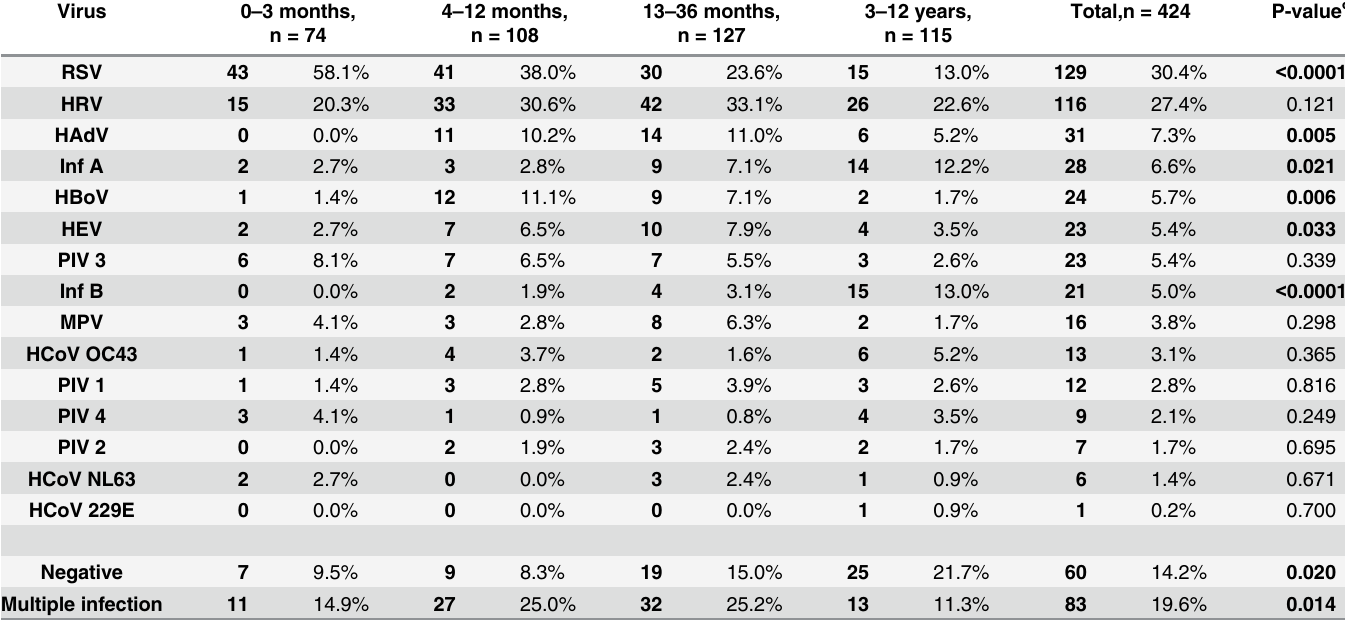
Table 2. Distribution of virus infection by patient age.